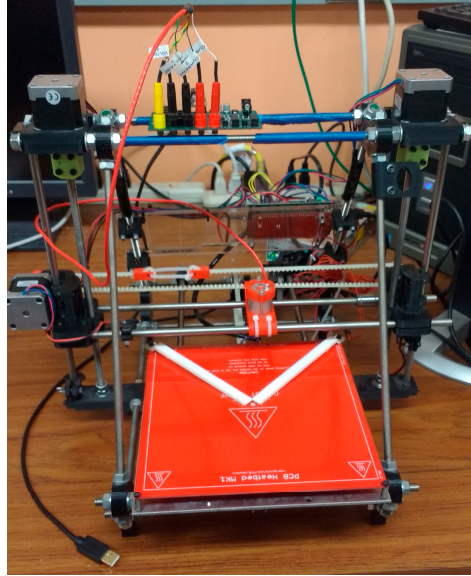
Figure 11. Modified 3-D printer with custom measurement circuit for OS4PP measurements.